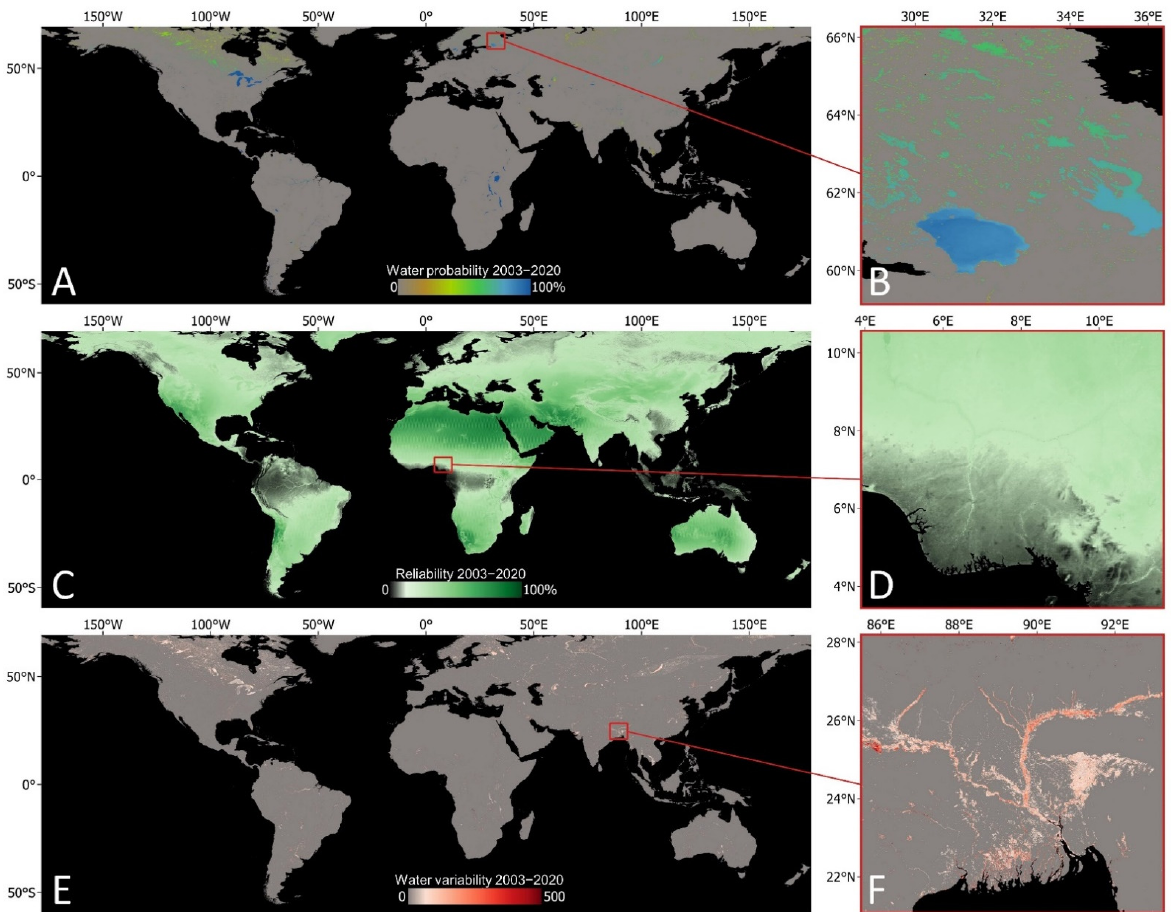
Figure 9. Global long-term water probability ( A , B ), reliability ( C , D ) and variability ( E , F ) for the years 2003–2020.